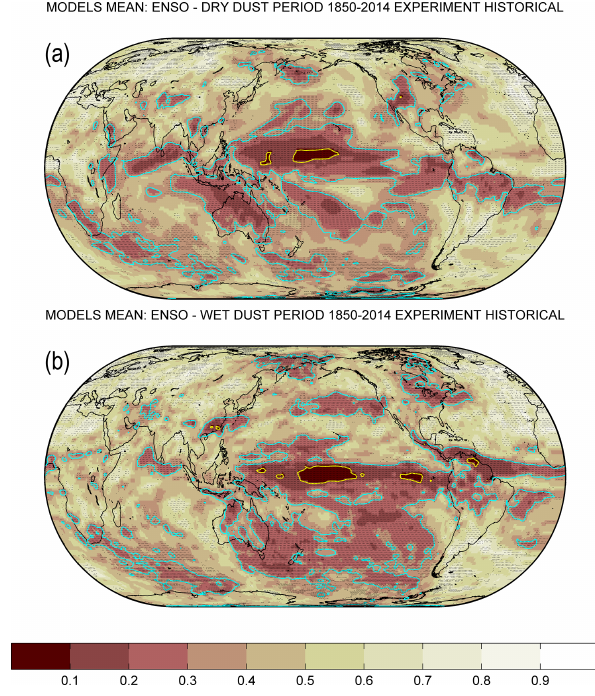
Figure 1. Multi-model mean probability map for the absence of Granger causality from ENSO to annual mean deposition rate of dry dust (a) and wet dust (b) over the period 1850–2014 of the historical experiment. Stippling indicates that no less than 70% of all models show agreement on the mean probability of total models at a given grid point. The agreement of an individual model is specified when the difference between the multi-model mean probability and the selected model’s probability is less than 1 standard deviation of the multi-model mean probability. The cyan and yellow contour lines specify p value = 0.33 and 0.1, respectively. Brown shades imply a low probability for no Granger causality. ENSO: El Niño–Southern